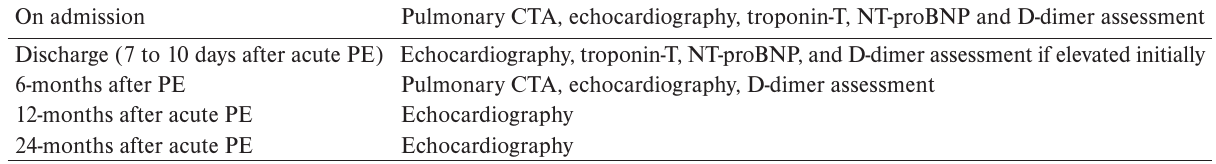
Table 1. Study dispensary protocol.